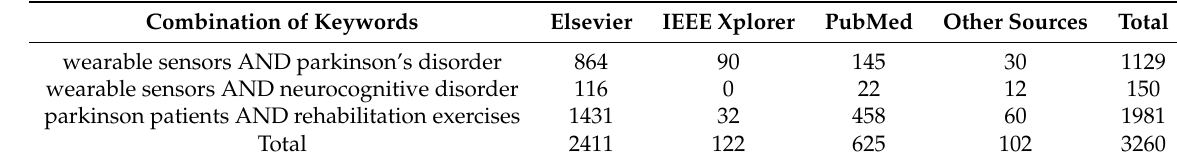
Figure 2. Stages adopted for the systematic selection of articles. Table 1. Numerical database search results.